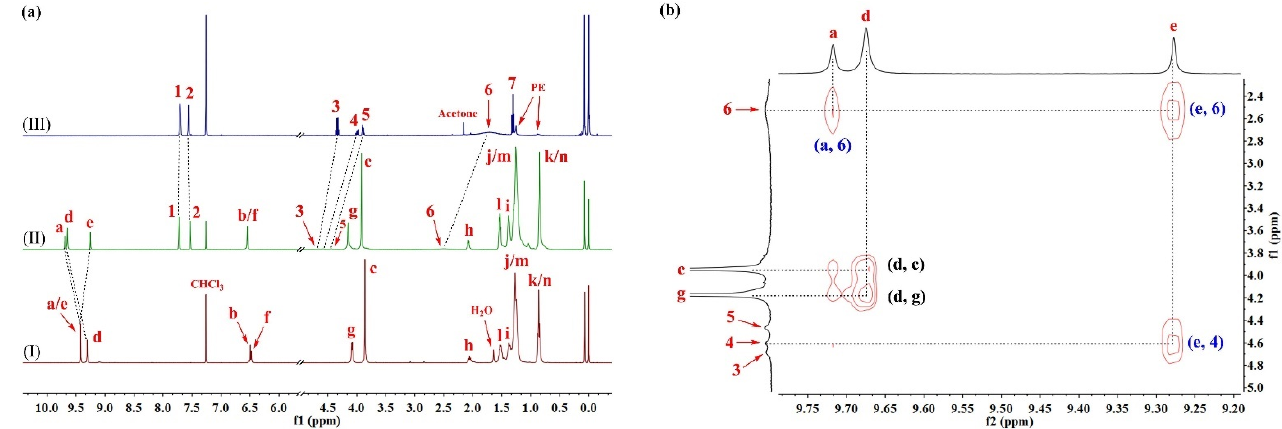
Figure 1. ( a ) Partial 1 H NMR spectra (400 MHz, CDCl 3 , 298 K) of (I) 1a (2.0 mM), (II) 1a ⊃ L1 (2.0 mM for each) and (III) L1 (2.0 mM). ( b ) Expanded 2D NOESY spectrum (600 MHz, CDCl 3 , 298 K, mixing time = 0.4 s) of 1a ⊃ L1 (10 mM for each).